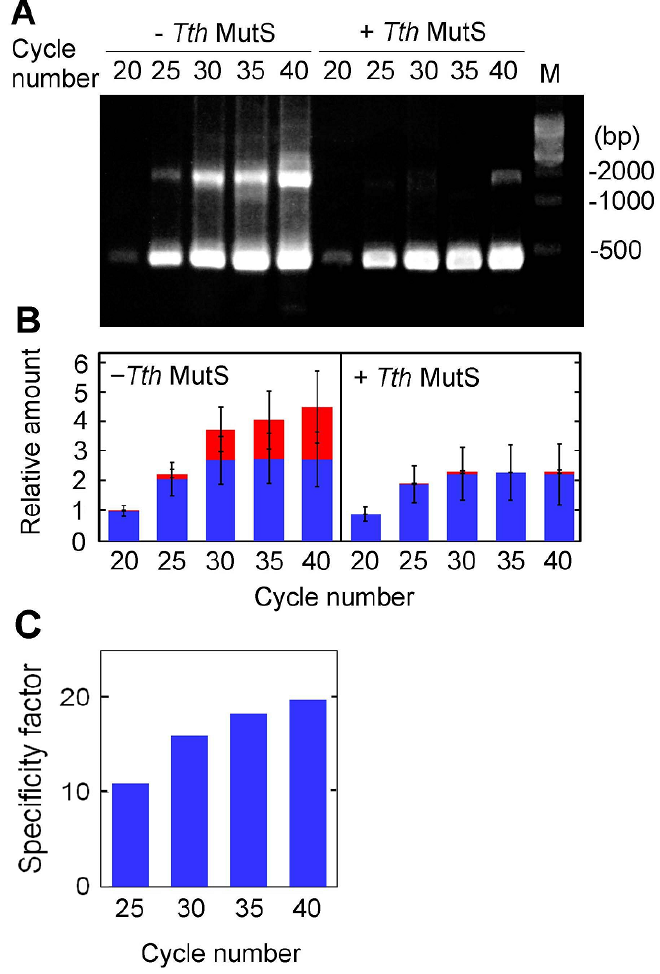
Figure 7. PCR cycle-dependence of the amplification of a 423-bp region of ttha1806 . ( A ) The amplification was performed in the presence or absence in 1.1 μ M Tth MutS and it was terminated at the end of 20, 25, 30, 35 or 40 PCR cycles. The 500-bp DNA ladder is indicated by the lane marked “M”; ( B ) The relative amounts of nonspecific and desired amplification products from (A) are shown in red and blue, respectively. The experiments were performed three times. Bars indicate standard deviations. The amounts of the products were normalized by the amount of total products at the end of twentieth cycle in the absence of Tth MutS; ( C ) Specificity factor for 1.1 μ M Tth MutS at each PCR